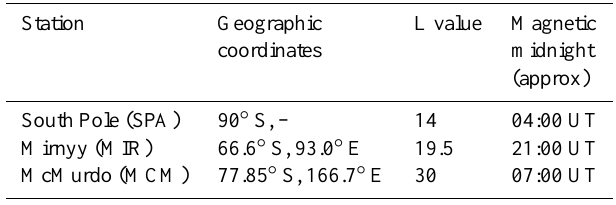
Figure 5: Diurnal event occurrence at very high latitudes